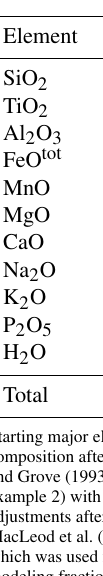
Table 2. Starting composition for modeling with